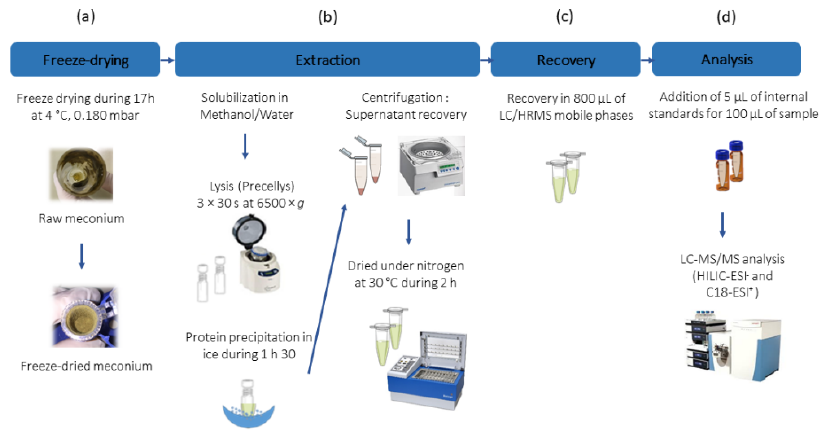
Figure 1. Optimized protocol for meconium preparation prior to LC-HRMS analysis. Four